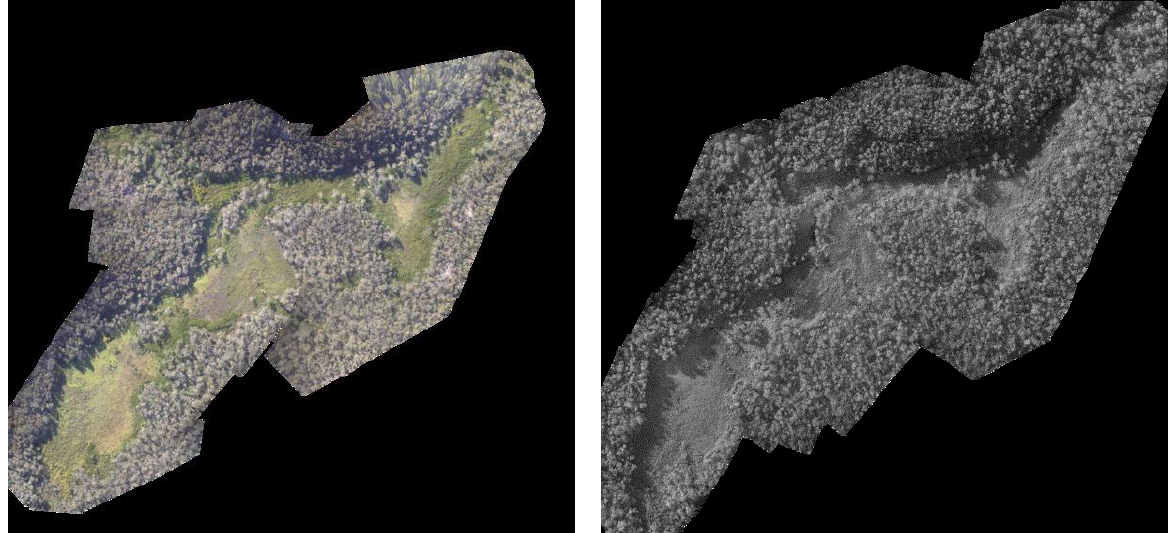
Figure 5: Ortho images for the visible (left) and the NIR spectrum (right) that have been obtained by combining both datasets into a single